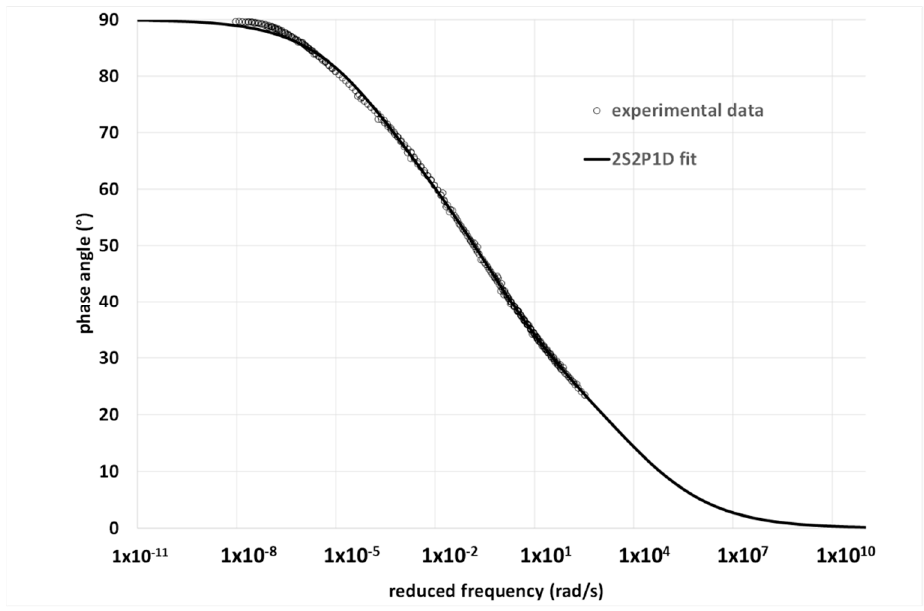
Figure 4. Phase-angle master curve of a Pen 35/50 bitumen. All details are given in [33].